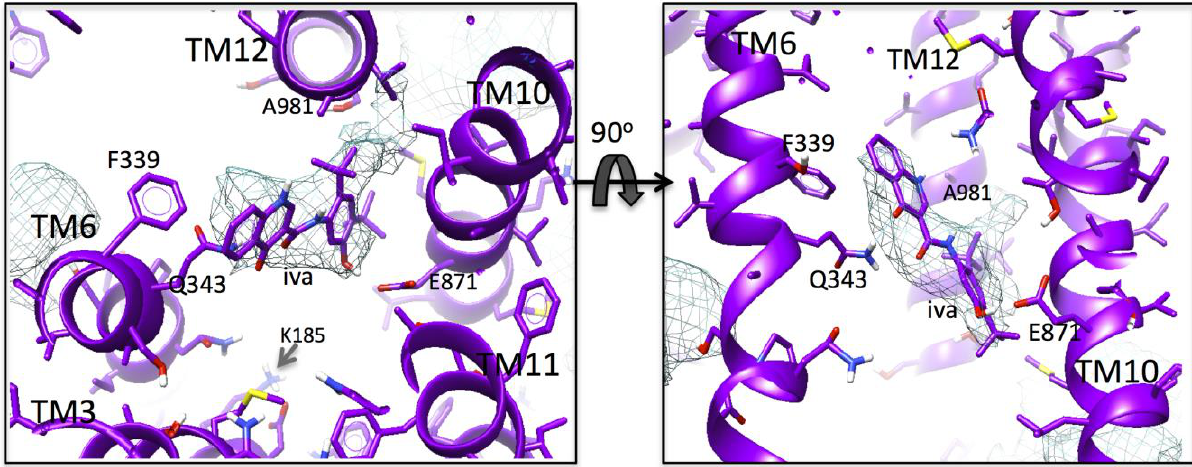
Figure 2. Additional density: Magnified, orthogonal views of additional density not accounted for by the fitted model in map a (blue mesh). The drug (iva) is modeled into the additional central density. The density is surrounded by residues in TM helices 6, 10, and 12 in the real-space refined atomic model. The 2,4 tert -butyl groups at one end of the ivacaftor molecule favored its orientation as shown within the rocket-shaped density. In this model, F339 and Q343 within TM6 could form π - π and H-bonding interactions with the ivacaftor quinoline group. Small (glycine) residues at 868 and 985 in TM helices 10 and 12 may be important for accommodating the bulky tert -butyl groups at the other end of the drug, and A981 may also satisfy hydrophobicity requirements for these groups. Similarly, H-bonding with E871 by the phenolic hydroxyl group of ivacaftor may occur in this fitting. K185 in TM3 extends up into the central cavity to within 10 Å of this